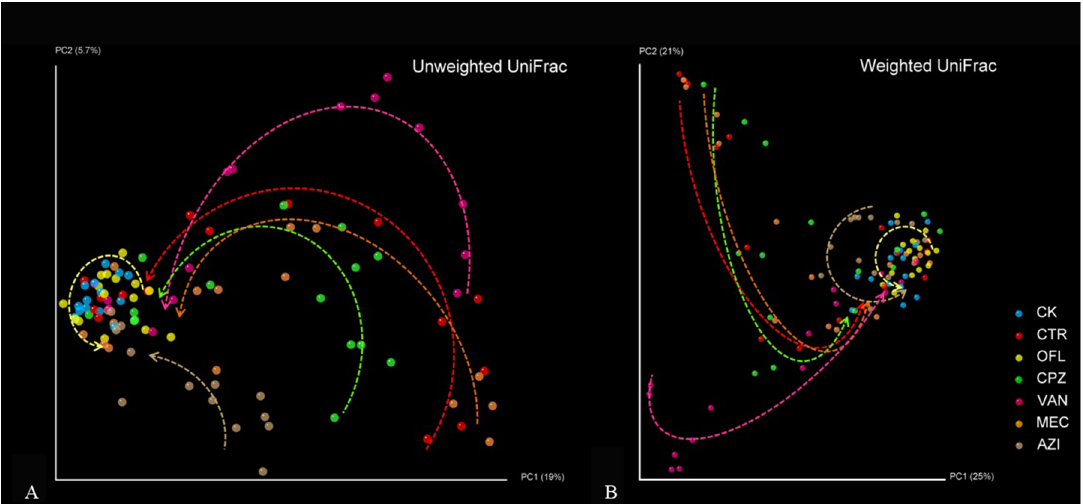
Fig 2. Principal coordinates analysis of unweighted and weighted UniFrac distances among different antibiotic groups. The starting points of the arrow lines are from the second day of antibiotic administration, and the arrow point is the end of observation period.